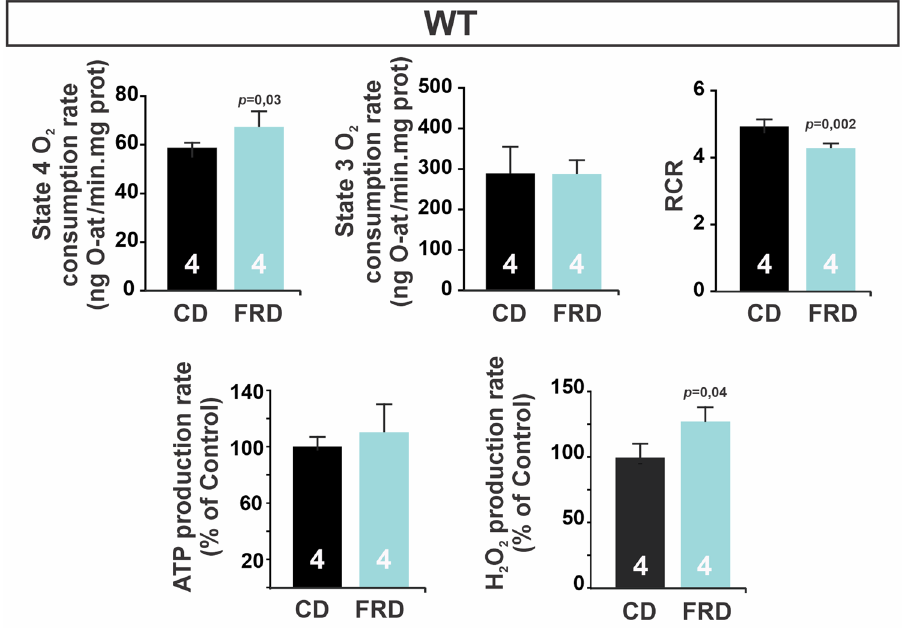
Figure 3. Mitochondrial metabolism is altered in prediabetic mice. The upper panel shows mitochondrial O 2 consumption rate in isolated mitochondria in State 4 (without extra ADP and excess of substrates), State 3 (with the addition of ADP), and Respiratory Control Ratio (RCR). RCR was calculated as a State 3/State 4 respiration rate. The bottom panel shows ATP and H 2 O 2 production rates expressed as % of CD group. All measurements were performed on isolated mitochondria using malate and glutamate as substrates. O 2 consumption in State 4 and